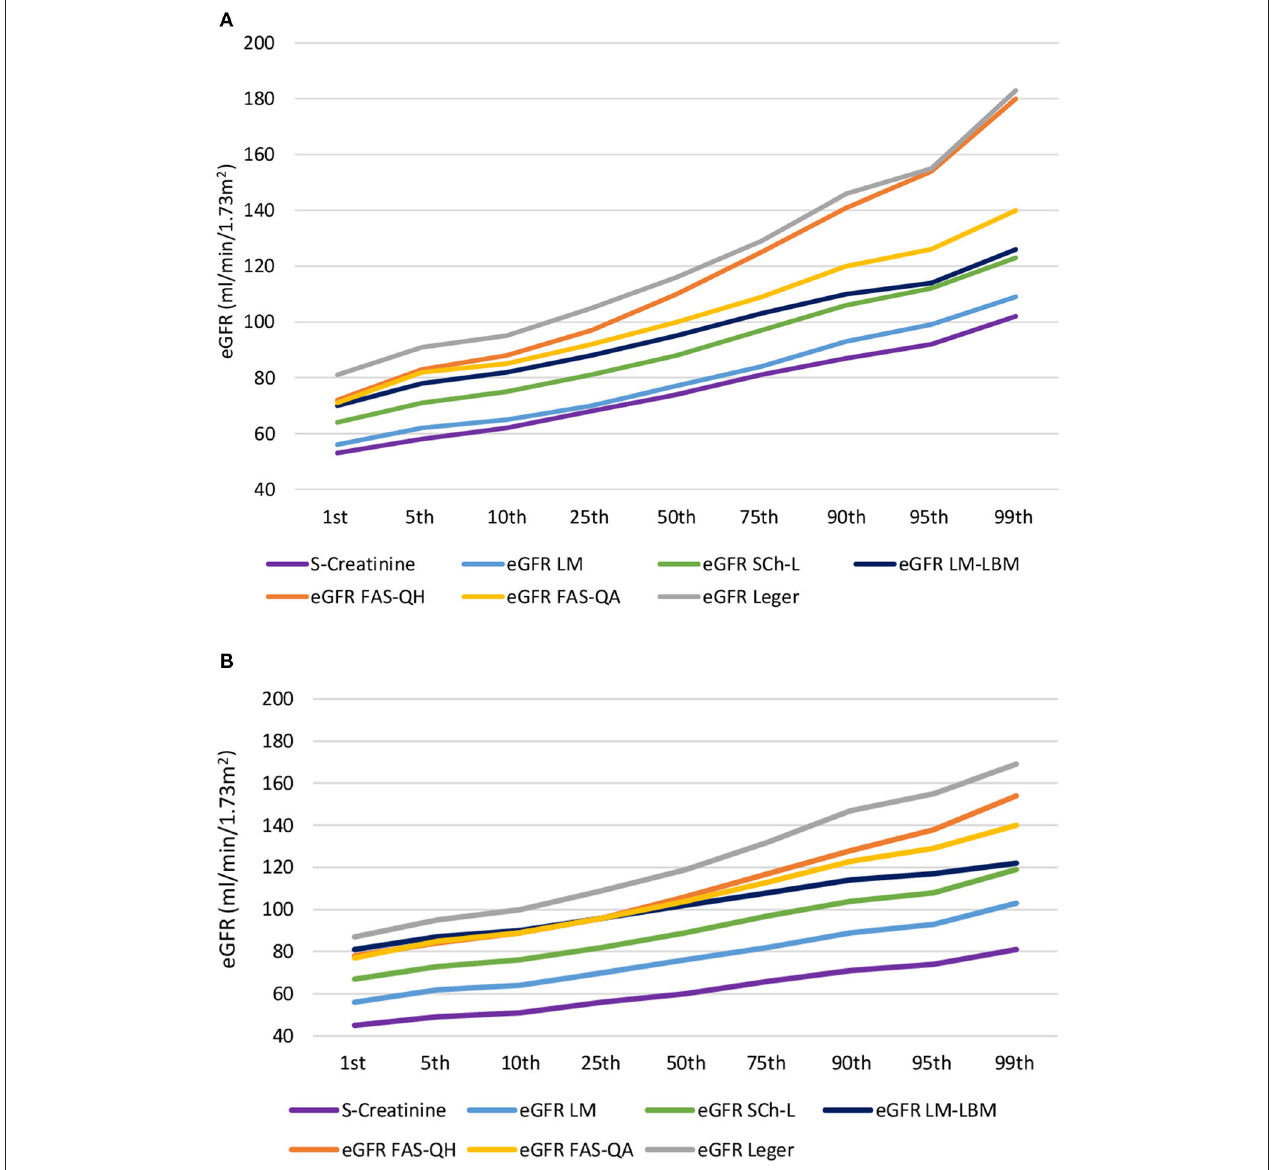
FIGURE 1 | Chart flow of serum creatinine concentration and estimated glomerular filtration rate values returned by six formulae across the 1st to 99th percentile in (A) males and (B) females. eGFR, estimated glomerular filtration rate; Sch-L, Schwartz-Lyon formula; LM, Lund-Malmö formula; LM-LBM, Lund-Malmö formula